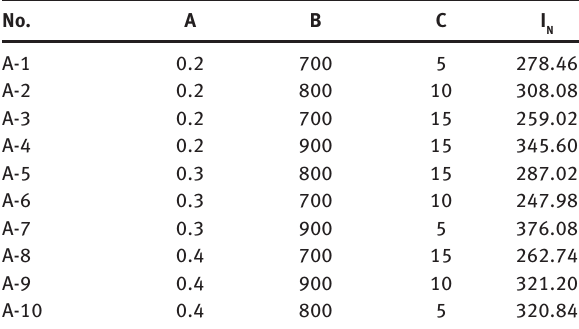
Table 5: Experimental conditions conducted in this